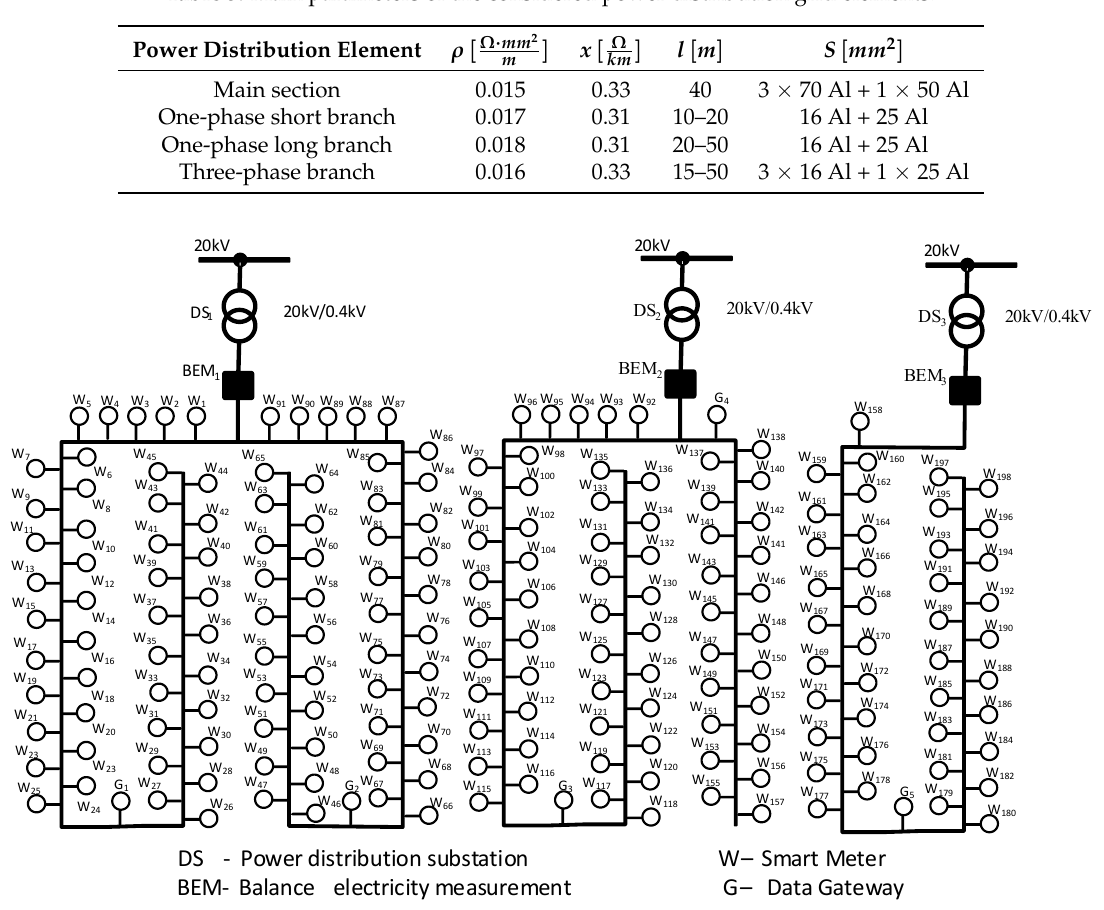
Table 3. Main parameters of the considered power distribution grid elements.